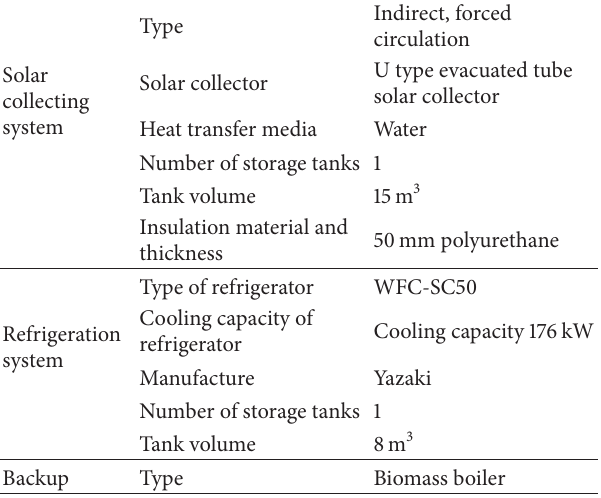
Table 12: Equipment for a solar air-conditioning